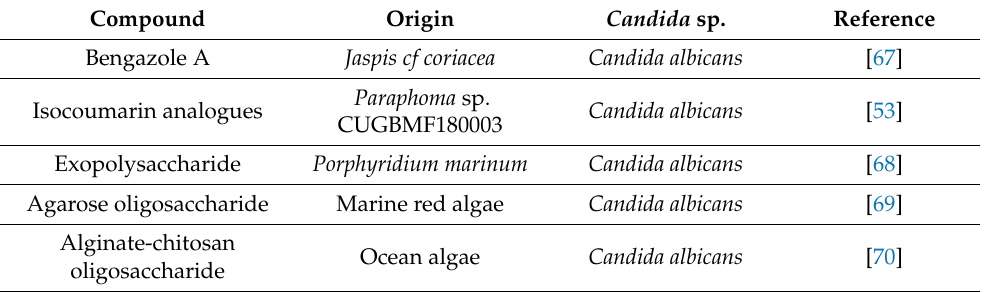
Table 5. Antifungal activity of marine